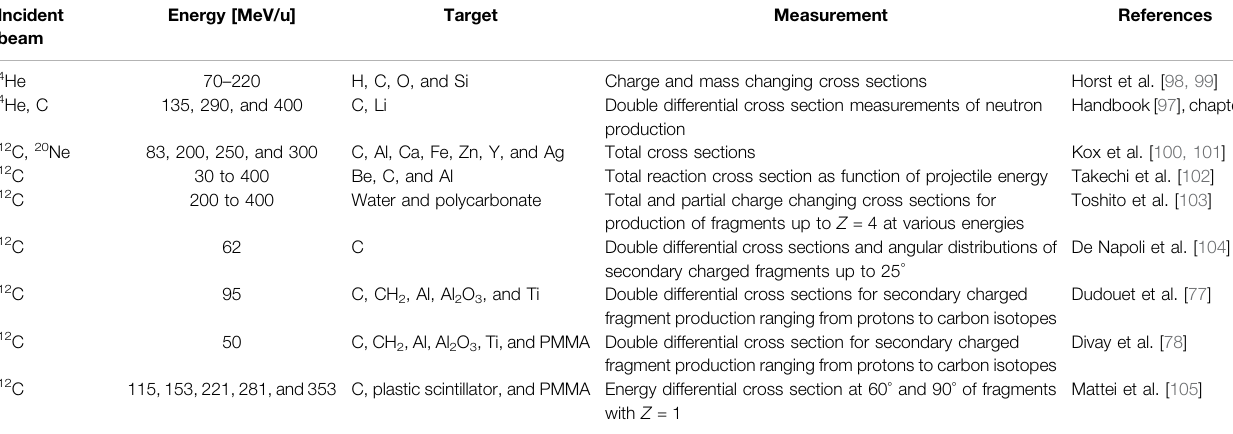
TABLE 1 | Cross section measurements on thin targets for tissue-like targets in the energy range up to 400 MeV/u. Incident Energy beam